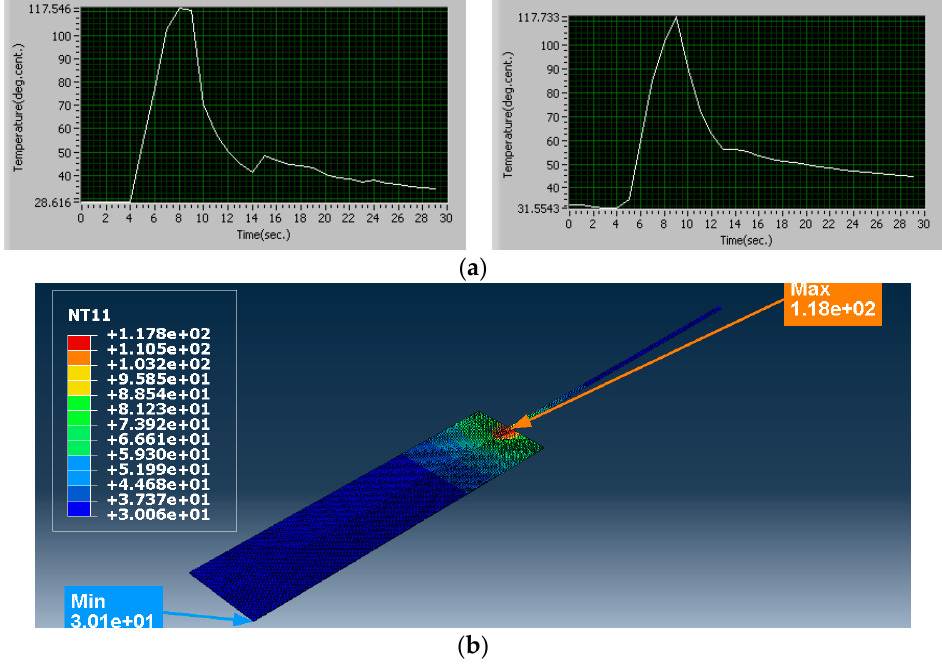
Figure 11. Trial 5, comparison of temperatures (°C): ( a ) results from experiments (Trial 5); and ( b ) result from simulation (Trial 5): Minimum temperature 30.06 °C, Maximum temperature 117.8 °C.